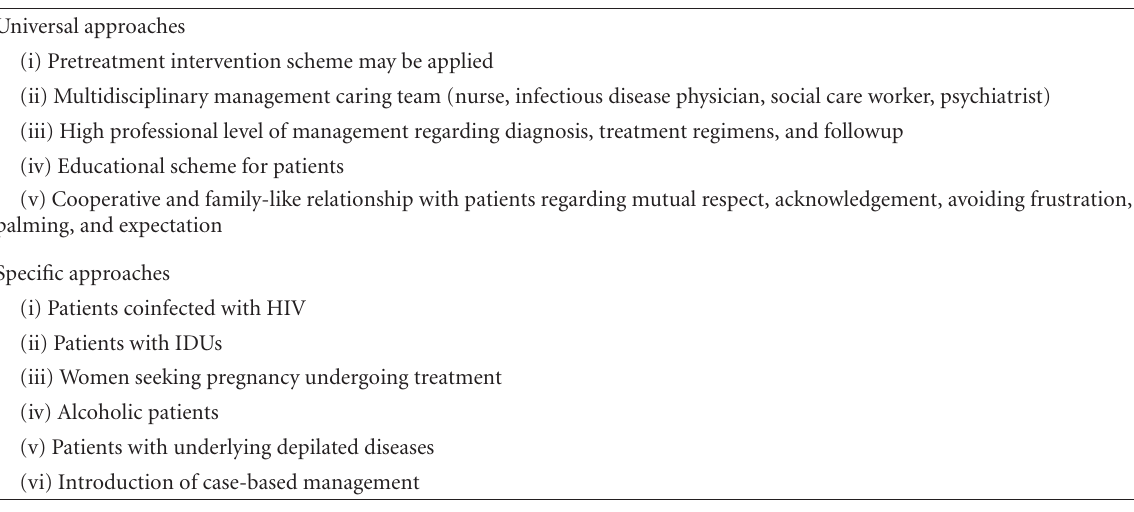
Table 2: Approaches to overcome factors influencing hepatitis C